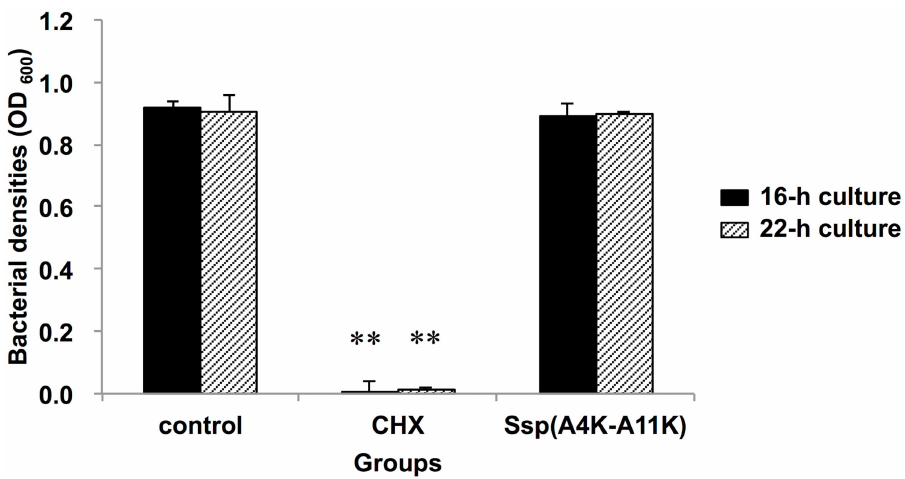
Fig 3. Bacterial growth in the presenceof Ssp(A4K-A11K) or CHX. Ssp(A4K-A11K) or 0.04% CHX (a positive control) were appliedto S . mutans cultures grown in BHI. The mixed suspensionswere incubatedfor 16 or 22 h followedby measurement of the opticaldensitiesat 600 nm. Data are expressedas the means ± SDs of three independentassays (vs. control: PBS-treated S . mutans ; ** P < 0.01).